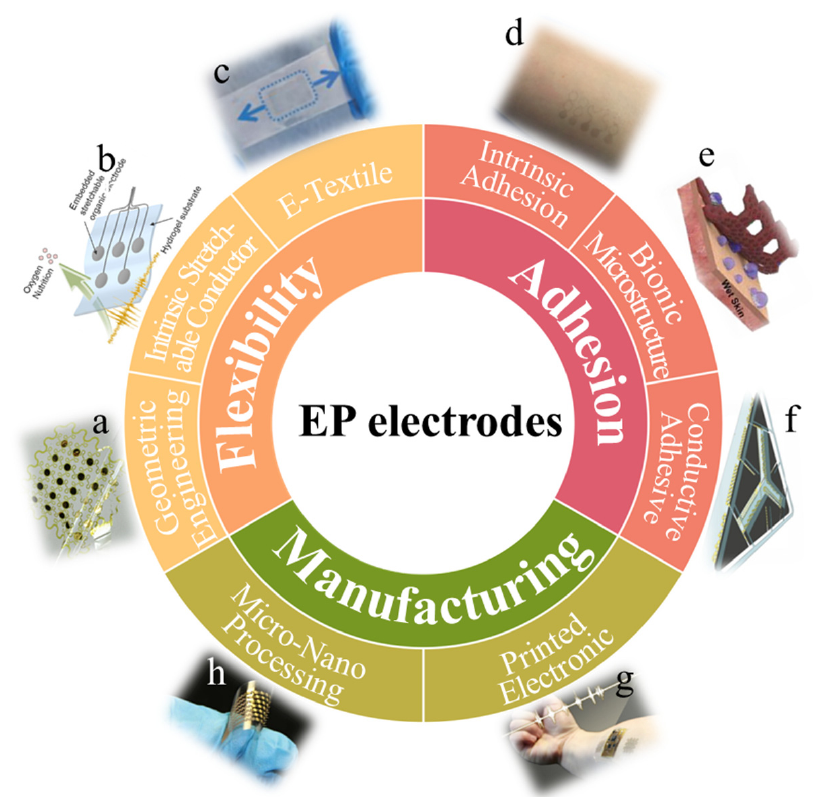
Figure 1. A summary of research on high-adhesive flexible bioelectrodes and their manufacturing methods. ( a ) Schematic diagram of an electrode of the island bridge structure of geometric engineering. Reproduced with permission from [24].